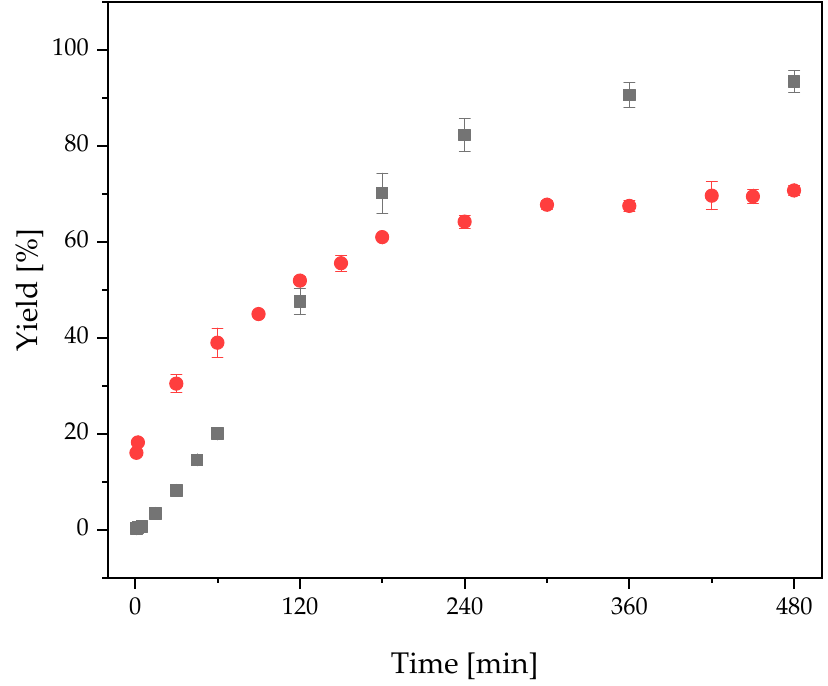
Figure 9. Time course of FOS relative yield by immobilized 1-FFT ( black , 5 g loaded carrier) and 1-FFT crude enzyme solution ( red , 10% ( v / v )).